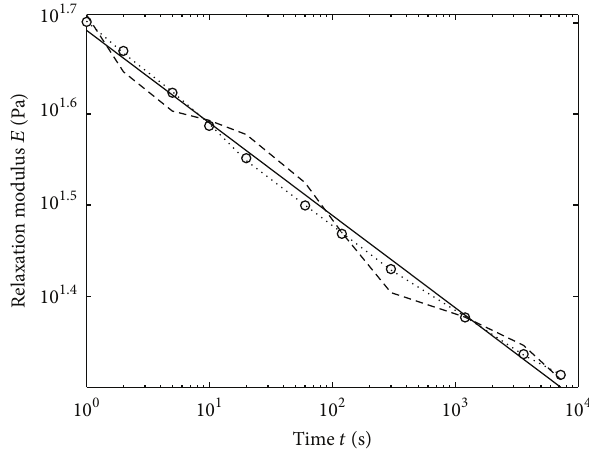
Figure 2: Relaxation modulus versus time for EVA at 60 ∘ C: experimental data (circles), predictions by the generalized Maxwell model with 3 arms (dashed line), by the generalized Maxwell model with 5 arms (dotted line), and by the springpot model based on fractional calculus (continuous